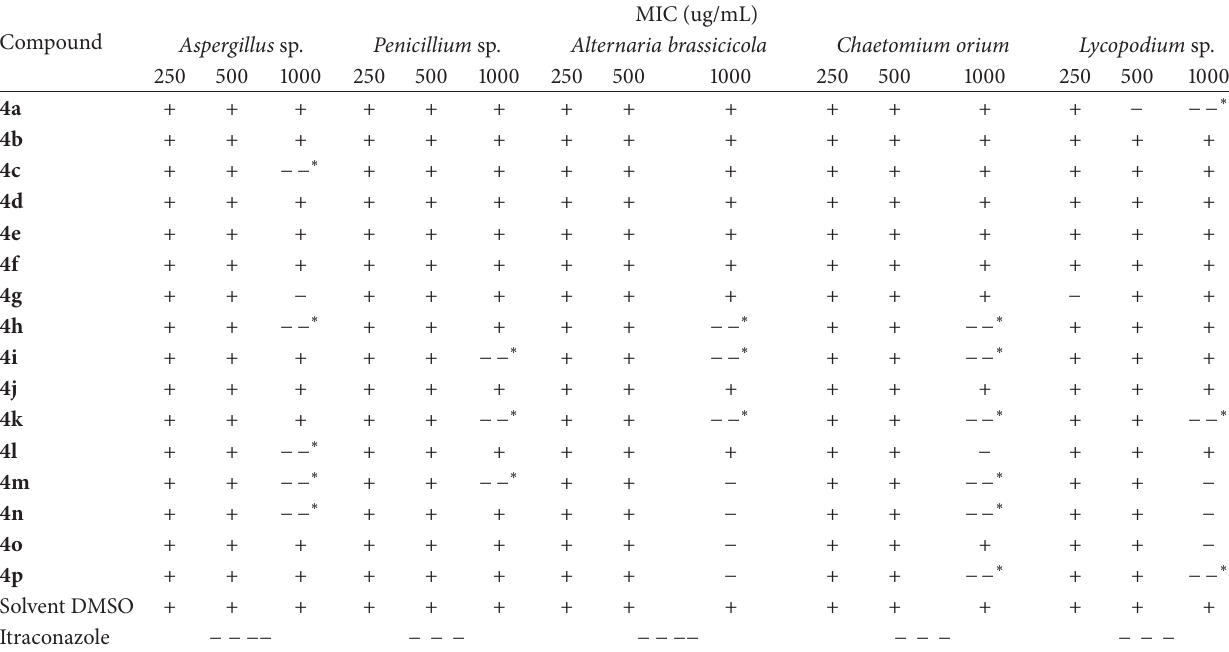
Table 3: Minimum inhibitory concentration for fungi.